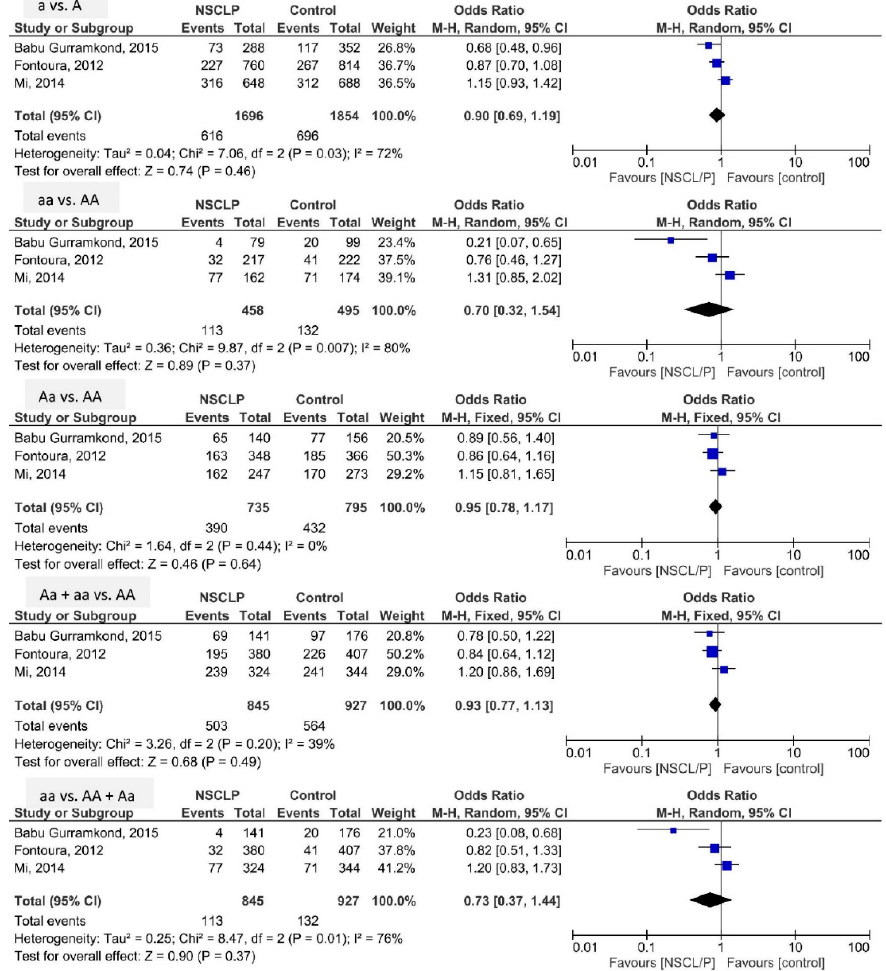
Figure 3. Forest plot of the odds ratio of the risk of non ‐ syndromic cleft lip/palate related to rs11696257 MAFB polymorphism.